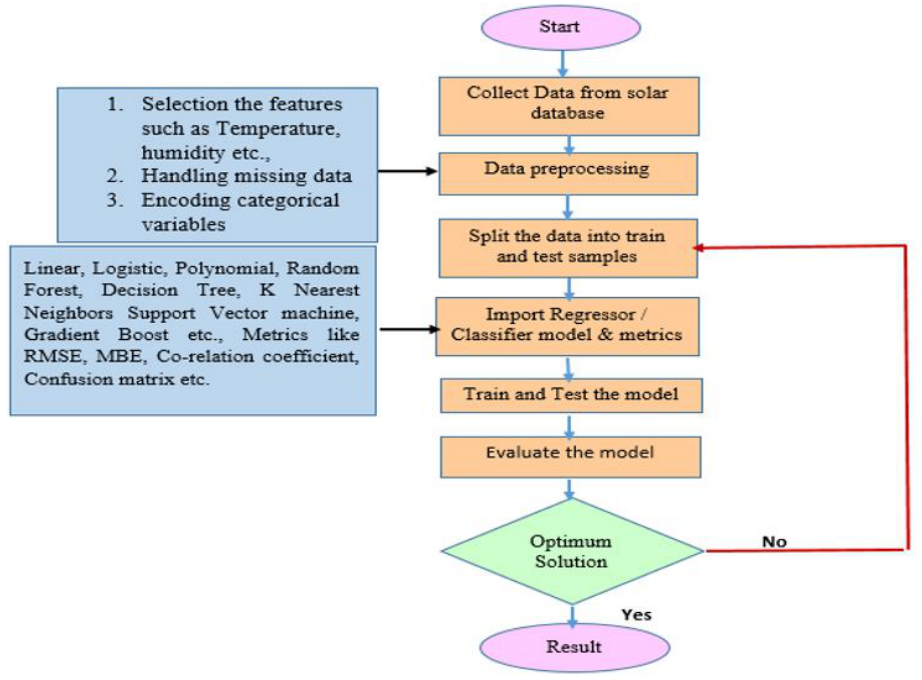
Figure 7. Flow chart for supervised machine learning models.